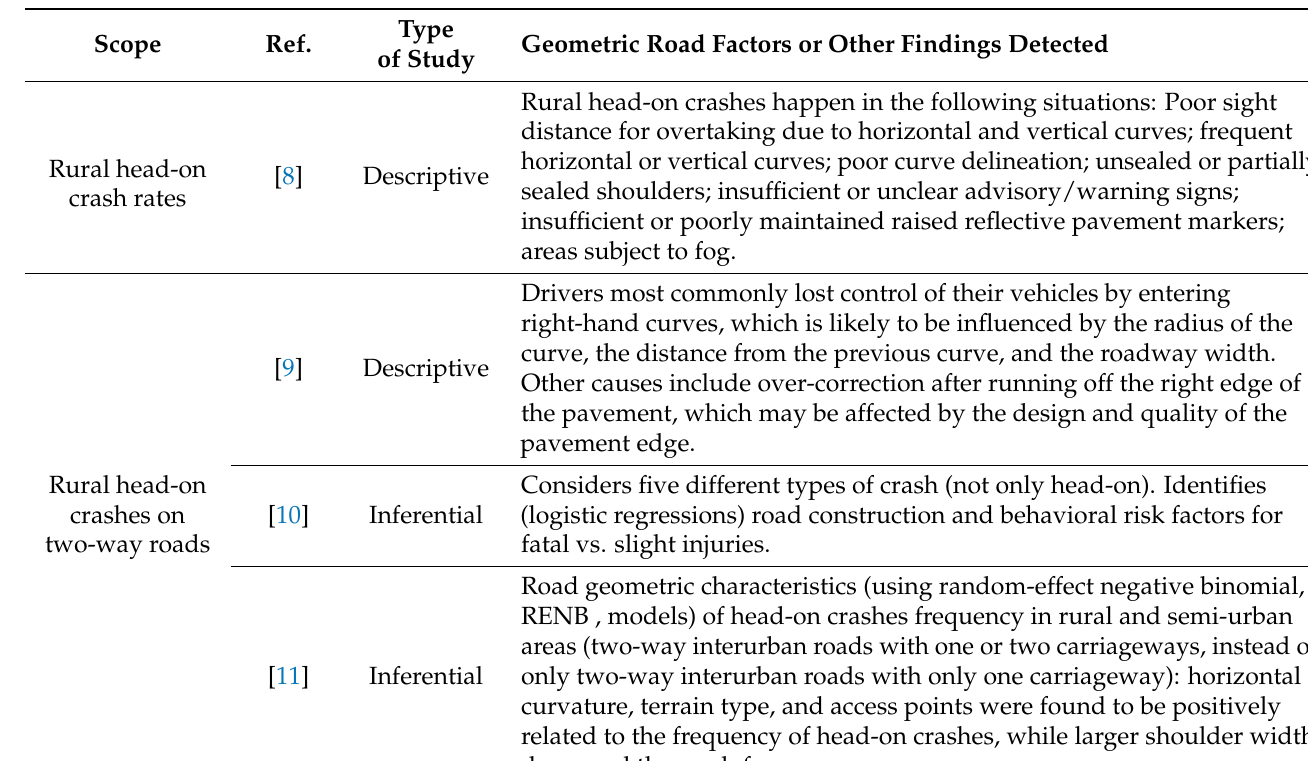
Table 1. Literature review